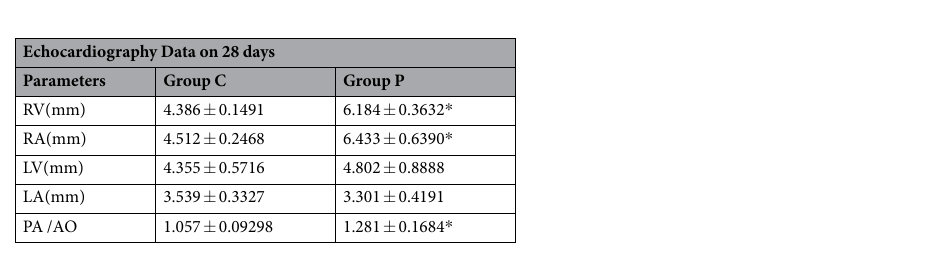
Table 2. Echocardiography examination results of rats in the PAH and control groups. n = 6, * Compare with Group C, p < 0.05.